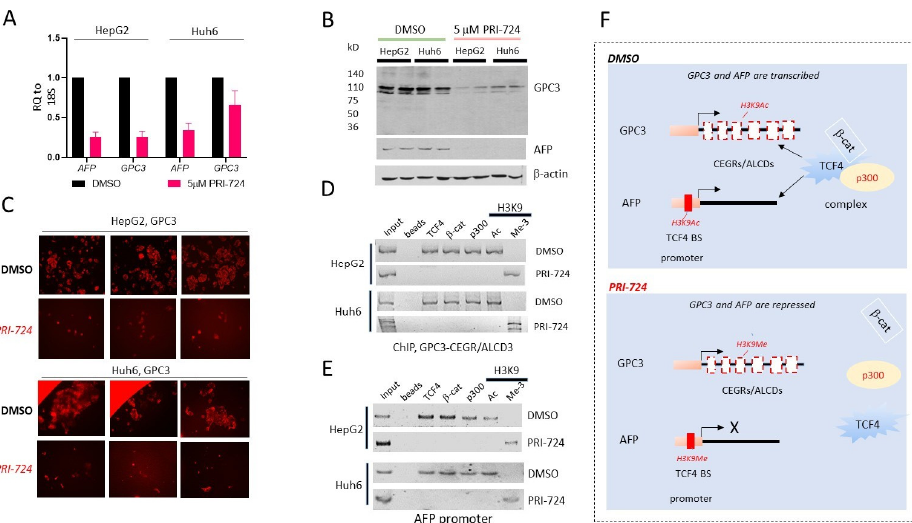
Figure 6. PRI-724-mediated inhibition of β -catenin activity in cancer cells reduces expression of GPC3 and AFP. ( A ) QRT-PCR of AFP and GPC3 in HepG2 ( AFP , p = 0.000037; GPC3 , p = 0.000059) and Huh6 ( AFP , p = 0.000240; GPC3 , p = 0.028805) cells (unpaired t -tests). ( B ) Western blots of GPC3 and AFP in DMSO or PRI-724-treated HepG2 and Huh6 cells. ( C ) Immunostaining of DMSO and PRI-724-treated HepG2 and Huh6 cells with antibodies to GPC3. ( D , E ) ChIP assay with the third CEGR/ALCD of the GPC3 gene ( D ), and AFP promoter ( E ). ( F ) Hypothetical mechanism of repression of the AFP and GPC3 genes in cancer cells treated with PRI-724.